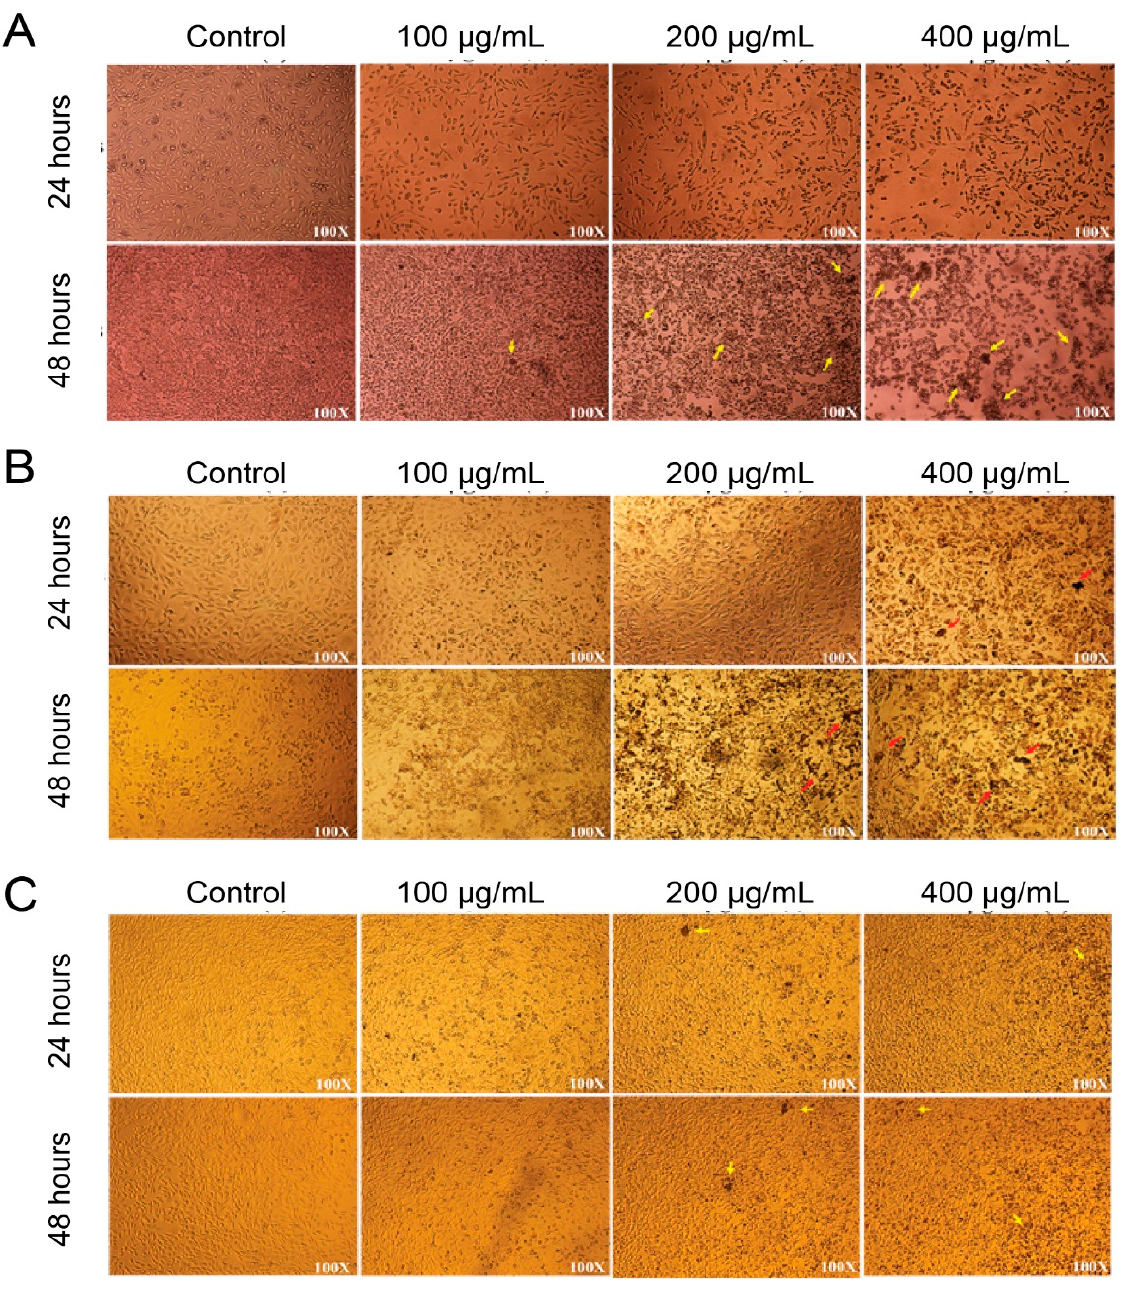
Figure 5. Microscopic images (×100 magnification) of nanoparticle-treated ( A ) HCT-116 colon cancer cells; ( B ) HELA; and ( C ) HFF-1 cells, for 24 h and 48 h with different P(St/AA) particle concentrations. The small yellow or red arrows indicate the brown debris of the dead cells.